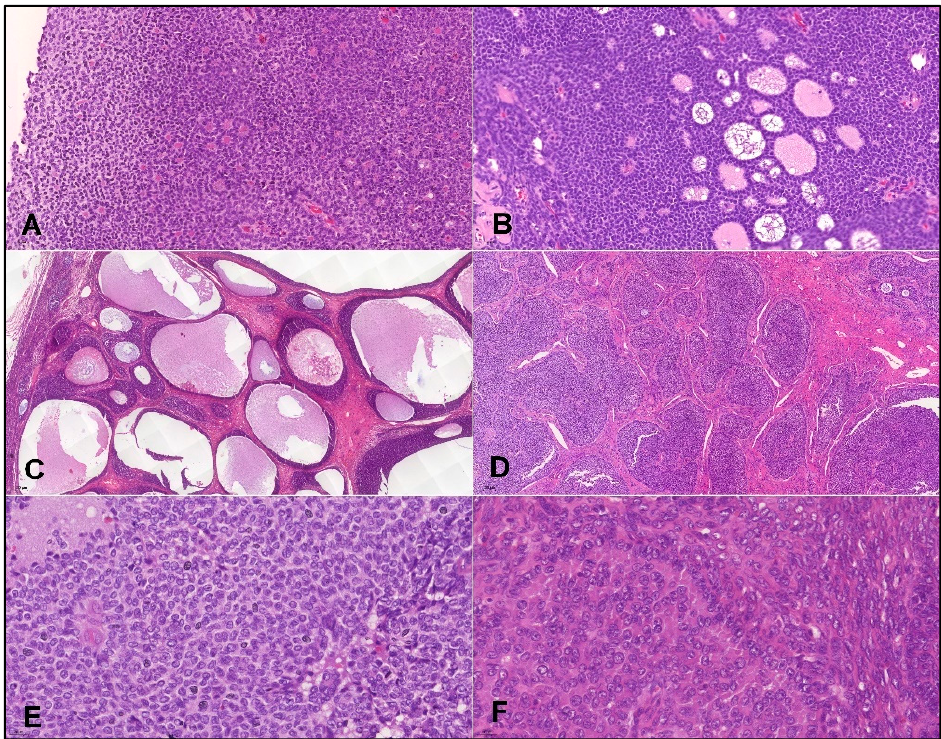
Figure 1. Representative images of HE staining in adult granulosa cell tumors. AGCTs show a variety of histology patterns, including solid, with the presence of: Call–Exner bodies ( A ), original magnification ×200; Microfollicular ( B ), original magnification ×200; Macrofollicular ( C ), original magnification ×50; or insular ( D ), original magnification ×50. Tumor cells have irregular nuclear membranes, oval nuclei, and nuclear grooves ( E ), original magnification ×400. Luteinized granulosa cell tumor cells have abundant eosinophilic cytoplasm and less conspicuous grooving of the nuclei ( F ), original magnification ×400.